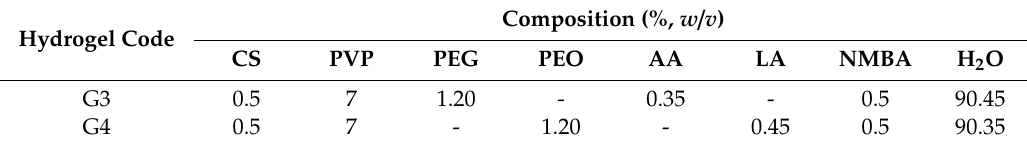
Table 8. Samples composition of hydrogels.